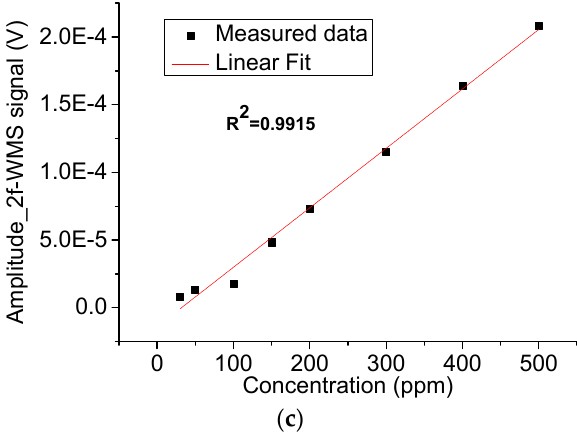
Figure 11. 2f-WMS Photoacoustic signal measured by electrical microphone for different NH 3 concentrations ( a ) X-component. ( b ) Amplitude and ( c ) Linear fitting. The pressure is set to 1 atm, and temperature to 296 K.